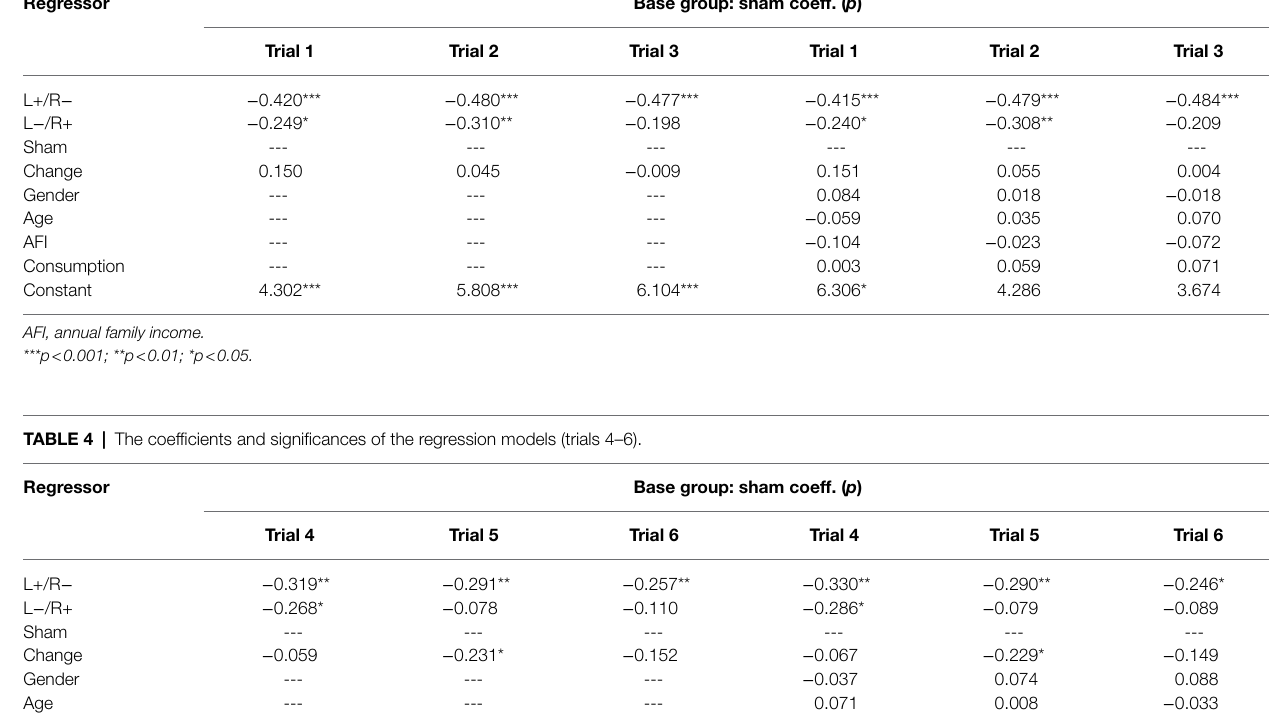
TABLE 3 | The coefficients and significances of the regression models (trials 1–3). Regressor Base group: sham coeff. ( p